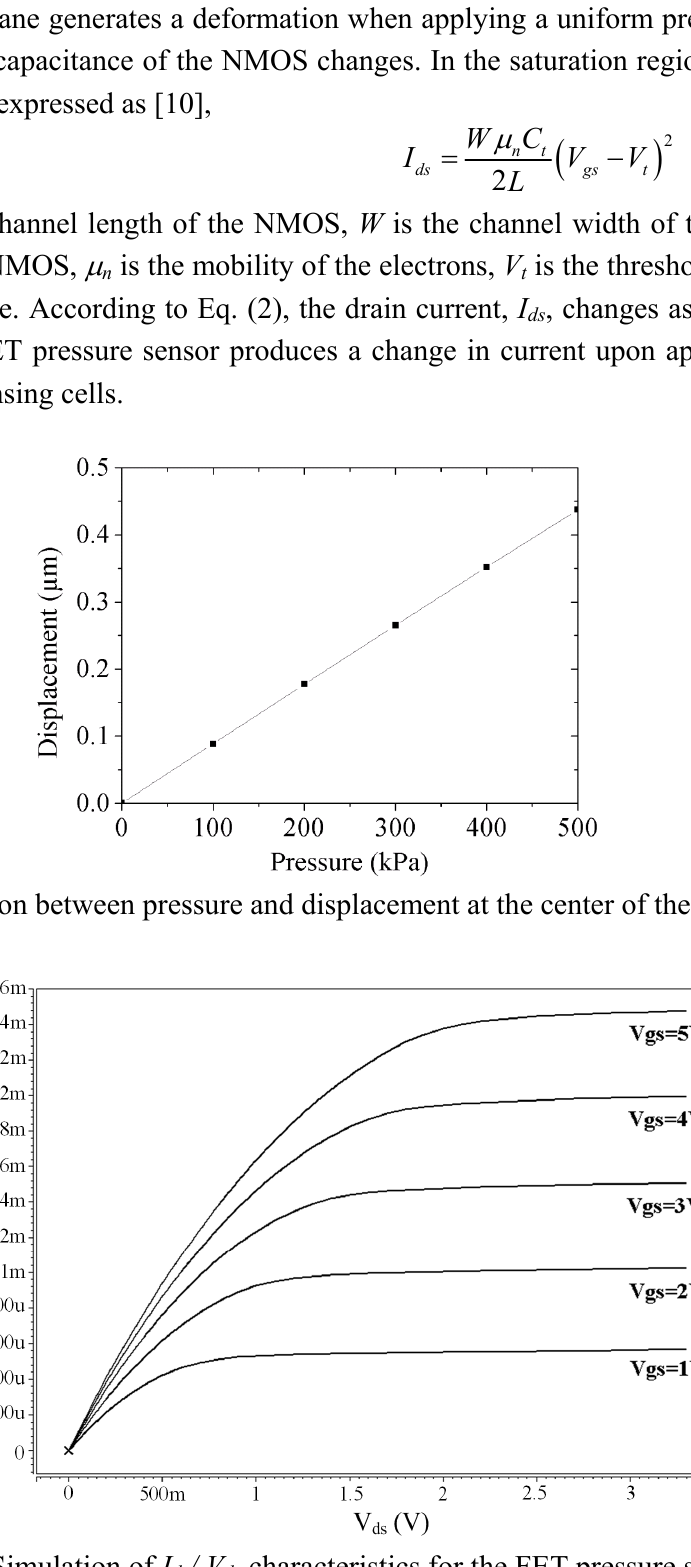
Figure 6. Simulation of I